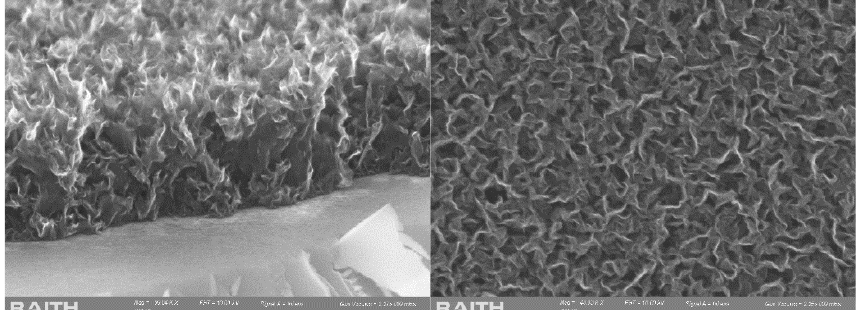
Figure 1. ( Left ) Cross-section image of VG grown on Si substrate; ( Right ) top view image of VG grown on Si substrate. The morphology of VG resembles vertical nanowalls with secondary nucleation sites on the vertical graphene sheets which results in a complex interconnected 3D morphology with secondary sheets growing from the sidewalls.